Question: Write a caption explaining this figure to a reader.
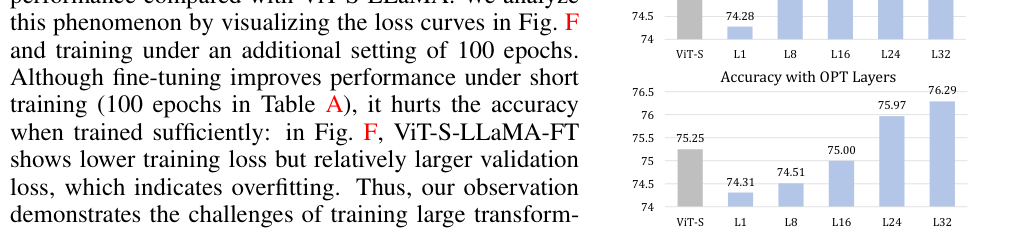
Answer: Various LLM transformer lay- ers improve the accuracy.